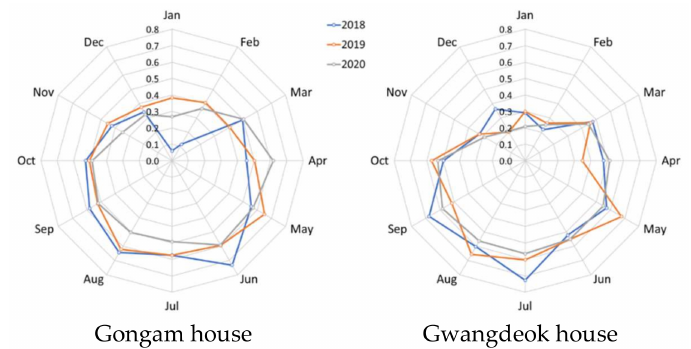
Figure 9. Monthly load cover factor.